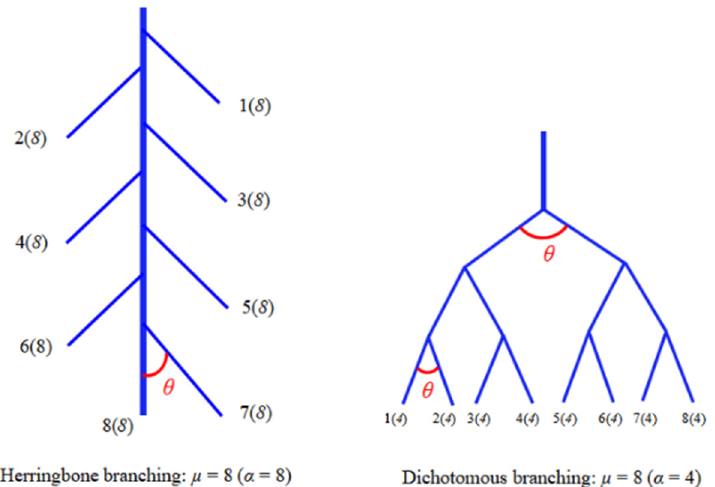
Figure 1. Diagram of root topology classification. α (altitude) is the number of internal links in the longest path from root collar to external tip, µ (magnitude) is the number of external links of the whole root system, and θ is the root branching angle. The TI of herringbone branching root and dichotomous branching root are 1 and 0.5, respectively. Herringbone branching root focuses on taproot development and consumes more costs, while dichotomous branching root focuses on lateral root development and consumes less costs.